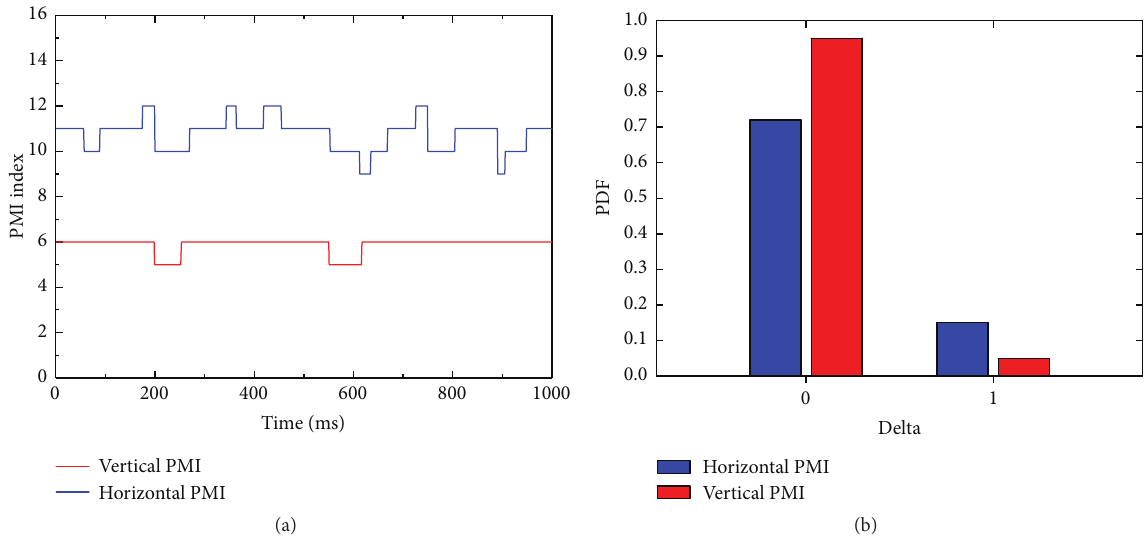
Figure 7: (a) The snapshot of time-domain PMI and (b) the statistical distribution histogram of PMI change every 5